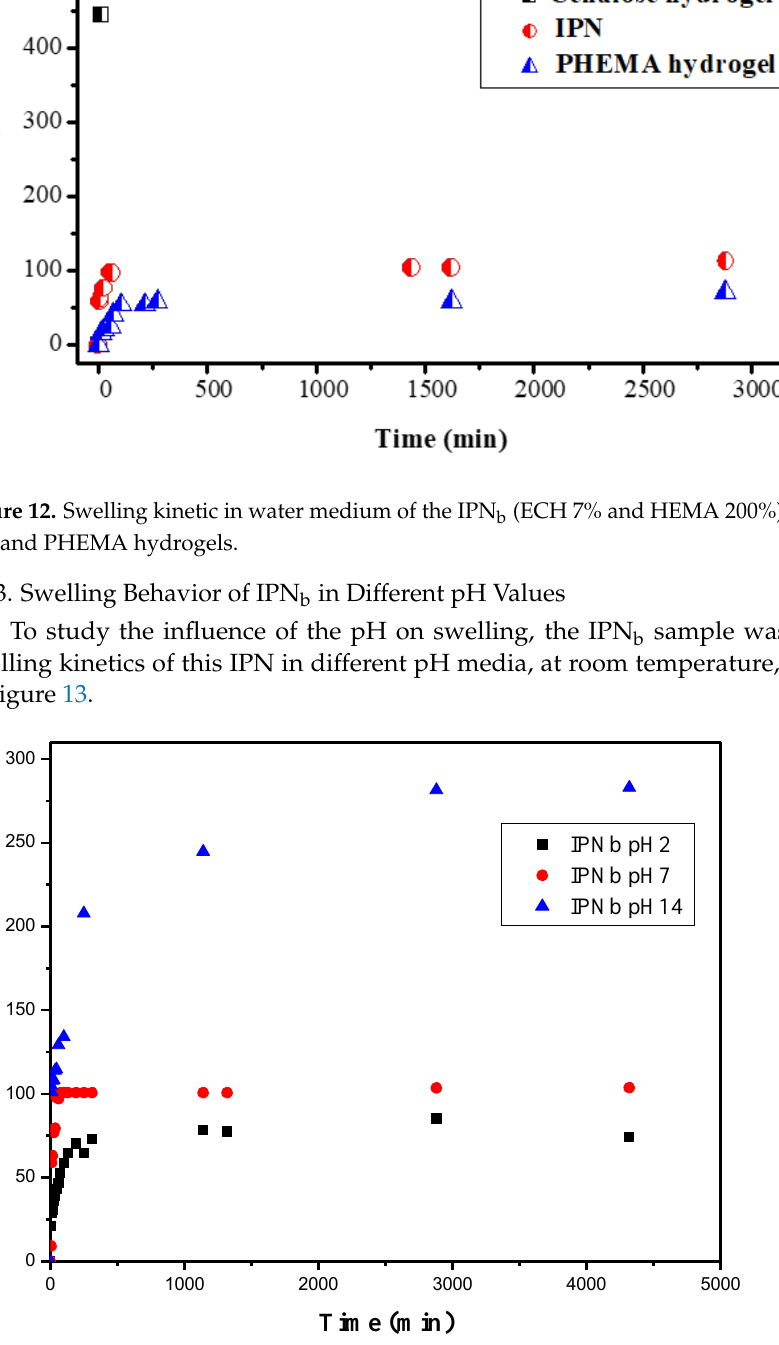
Figure 13. Swelling kinetics of the IPN b with ECH 7% and HEMA 200%, in aqueous media of different values of pH.